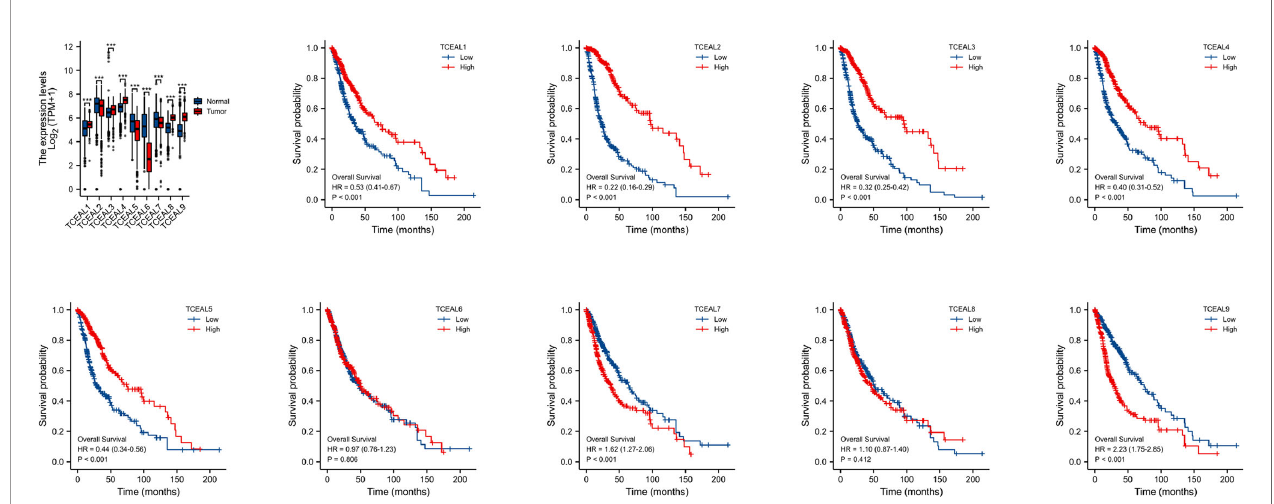
FIGURE 4 | mRNA expression of TCEAL family in GBM and the prognostic value of TCEAL family mRNA expression for OS in GBM patients by Kaplan – Meier analysis. GBM, glioblastoma multiforme; OS, overall survival ns, p ≥ 0.05; *p< 0.05; **p<0.01;